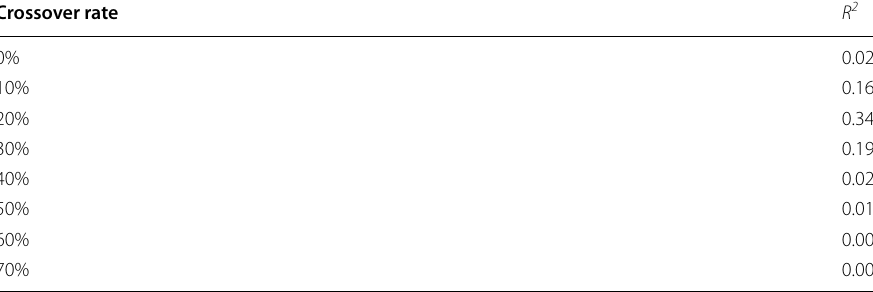
Table 6 Impact on performance for each crossover rate Crossover